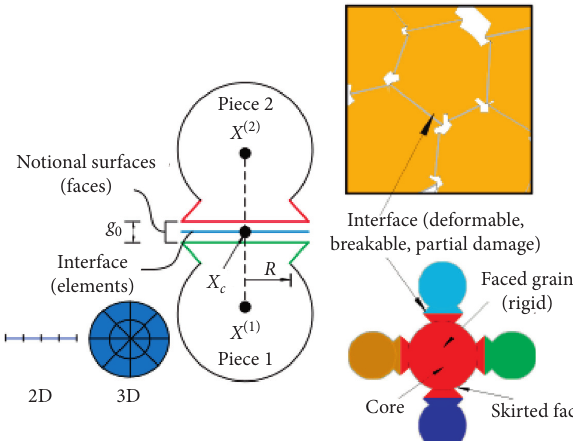
Figure 7: Flat-joint contact (left) and flat-jointed material